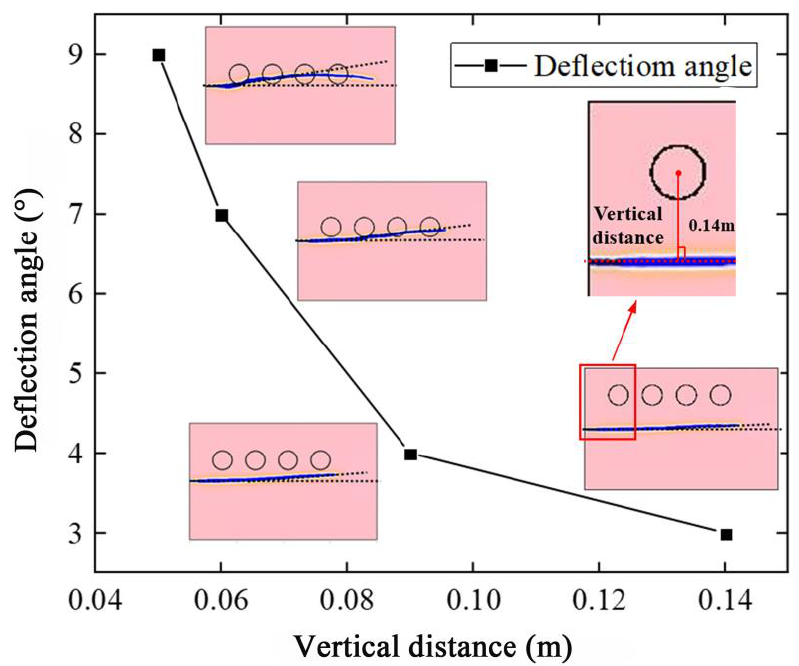
Figure 4. Deflection angle of the cracks under different vertical